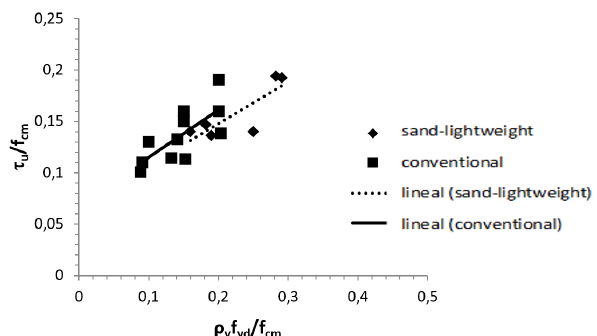
Figure 11. Influence of the clamping stress of the transverse reinforcement ( / )